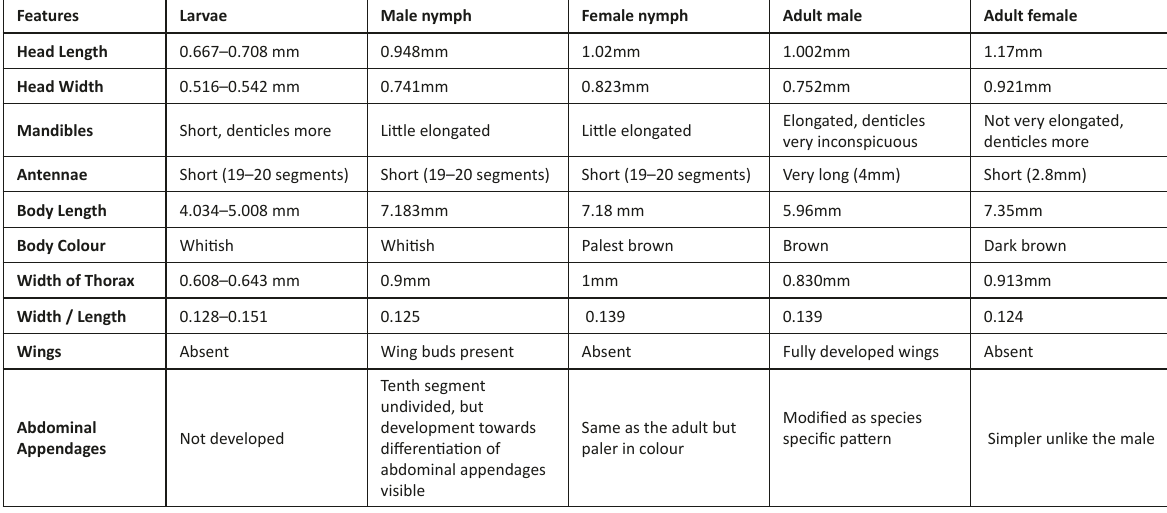
Table 1. Comparative morphology of different stages of the